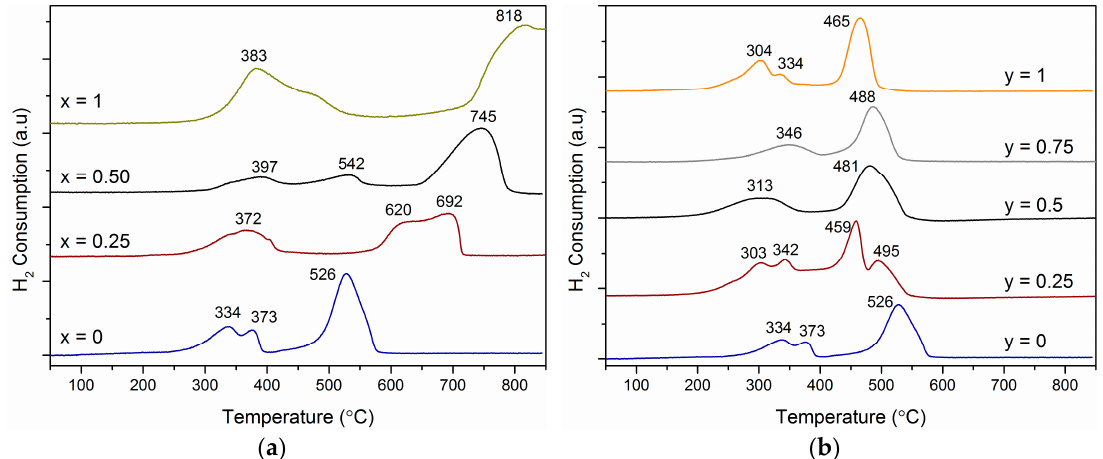
Figure 5. TPR profiles of: ( a ) LaCo 1 – x Mn x O 3 ; ( b ) LaCo 1 – y Ni y O 3 perovskites.